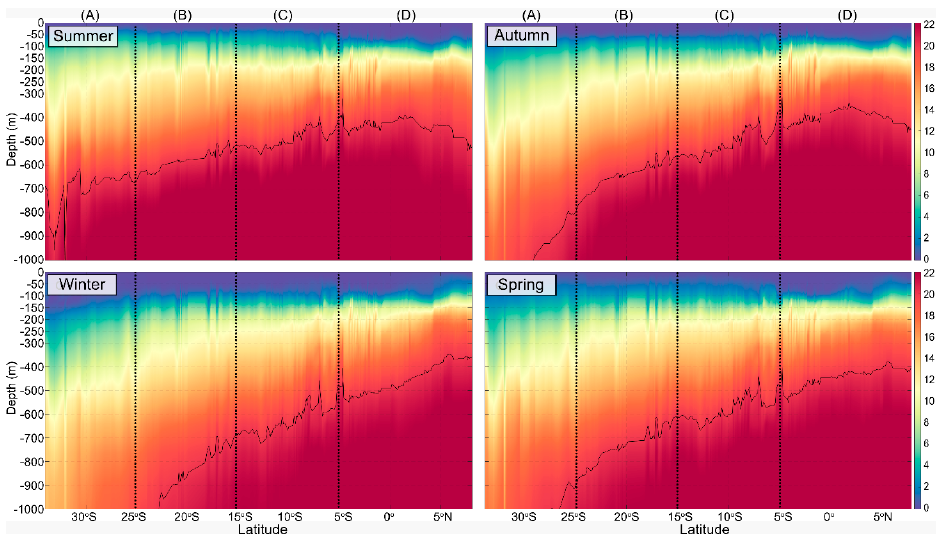
Figure 17. Seasonal (summer, autumn, winter, and spring) mean Δ T (°C) between 20 and 1000 m for the bathymetry of 1000 m (for regions A, B, C and D) across the Brazilian coastline latitude considering the period between January 1, 2007 and December 31, 2017. The black line corresponds to a Δ T of 20 °C. Table 6. Gross and net power estimation for the selected points along the Brazilian coastline. Regions Points Lat / Lon Bathymetry